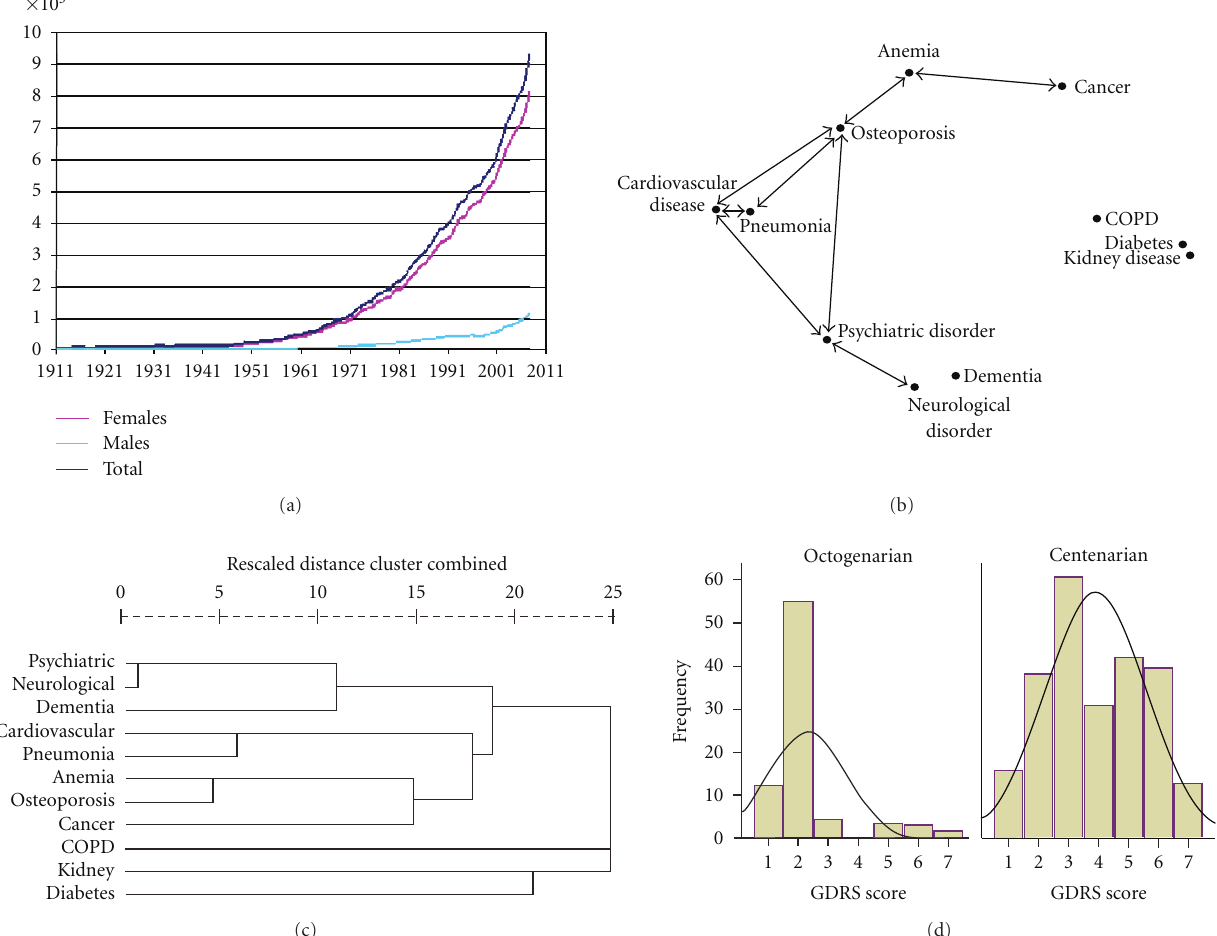
Figure 1: (a) Exponential growth of Centenarians in England over the last century [2]. (b) Network of morbidity in centenarians in the GCS [3] using lifetime prevalence of 11 most common chronic diseases in the GCS. All pairwise associations that were not significant by an exact test were set to zero, and the remaining significant (with α = 0.05) pairwise correlations ( r xy ) between chronic diseases x and y were all positive. These significant pairwise positive associations were graphically rendered using the distance 1- r xy and multi-dimensional scaling [9] to compute coordinates for the chronic diseases. The coordinates were then graphed as a network [10]. COPD denotes chronic pulmonary obstruction disease. Chronic and acute pneumonia were not distinguished in the medical questionnaire. (c) Average linkage [11] was used to compute a dendrogram independently relating the 11 chronic diseases based on their pairwise correlations r xy . (d) The distribution of GDRS scores [12] in centenarians is compared with the distribution of GDRS scores in 80 octogenarians as a control group. A GDRS score of 4–7 is indicative of dementia, a score of 3, of mild cognitive impairment, and a score of 1-2, as una ff ected. counties in 4 strata, which were compared for